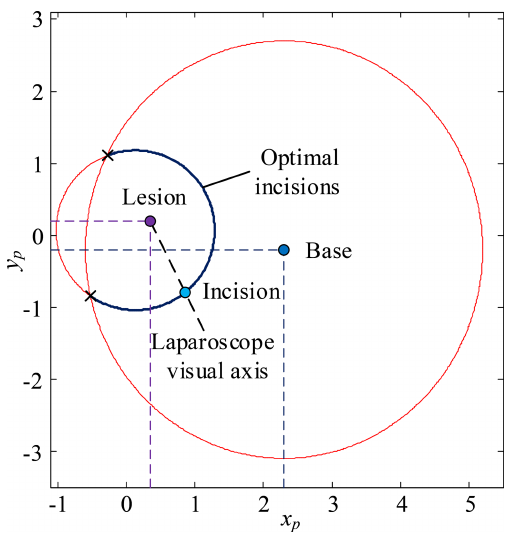
Figure 12. The sketch map of the optimum incision and angle.